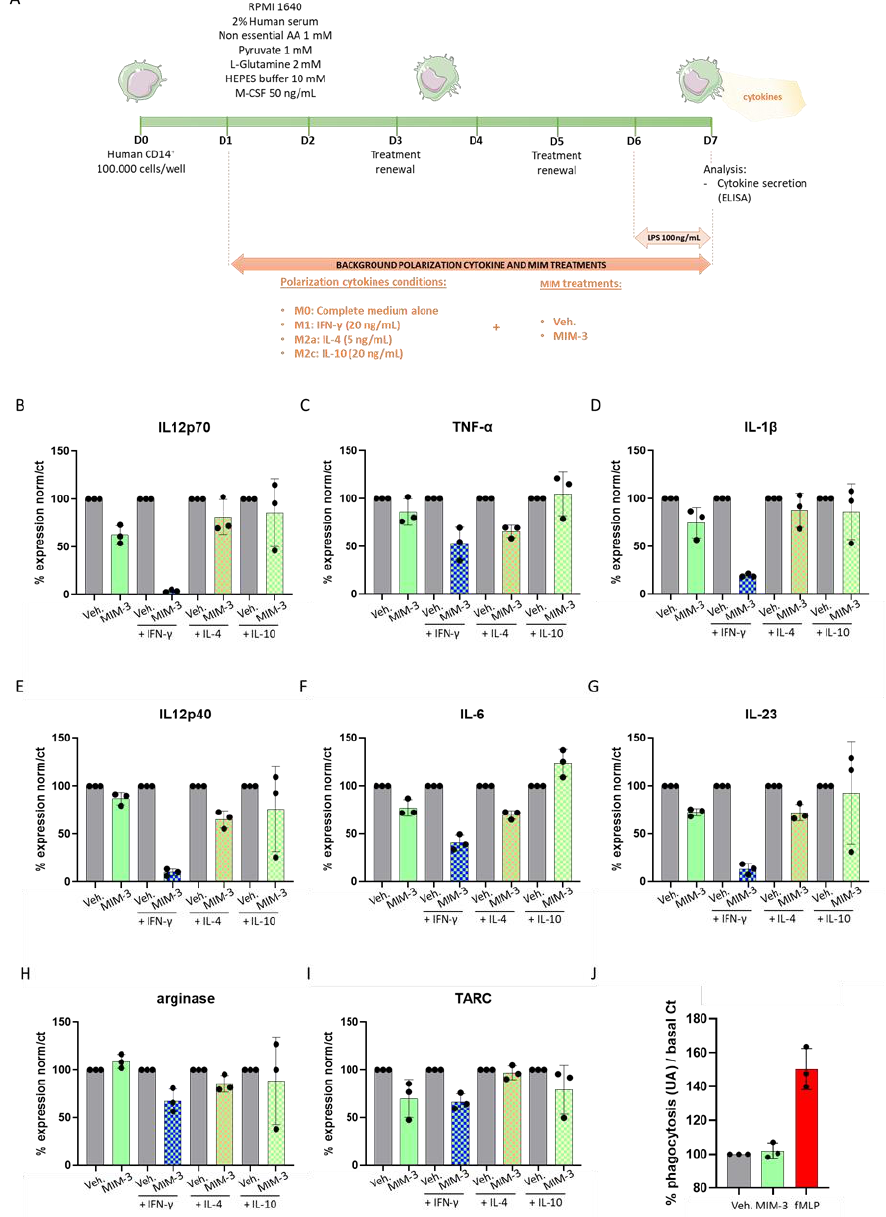
Figure 1. MIM-3 acts as an immune-modulator of macrophages’ cytokine secretion without affecting the phagocytosis capabilities of granulocytes. ( A ). Representative scheme of the CD14 + -derived macrophages’ cytokine secretion assessment protocol. CD14 + cells were obtained from peripheral blood mononuclear cells (PBMCs) isolated from one healthy donor and cultivated for 6 days in complete medium supplemented with M-CSF 50 ng/mL alone (M0), IFN- γ at 20 ng/mL (M1), IL-4 at 5 ng/mL (M2a), or IL-10 at 20 ng/mL (M2c), as background polarization cytokines and in the presence of either MIM-3 or vehicle (Veh.). An additional 24 h of LPS treatment (100 ng/mL) were applied as an inducer of an inflammatory status during the last day of the MIM-3/Veh. treatment. AA: amino acids. Cytokine secretion was evaluated by ELISA. ( B – I ) Effect of MIM-3 on the secretion of the cytokines: IL12p70, TNF- α, IL - 1β, IL12p40, IL -6, IL-23, arginase and TARC. The results are expressed in percentage of the cytokine secretion in the Veh. -treated conditions, the Veh. being set at 100% for each one of the differentiation backgrounds. The M1-macrophages induced by IFN- γ and treated with MIM-3 are represented with the green- and blue-squared histograms, the M2a macrophages induced by IL-4 and treated with MIM-3 are represented with the green- and pink- squared histograms, and the M2c macrophages induced by IL-10 and treated with MIM-3 are represented with the green- and yellow-squared histograms. Each condition has been performed in triplicate. ( J ) Human granulocytes were preincubated for 10 min with MIM-3, or vehicle (Veh.), or